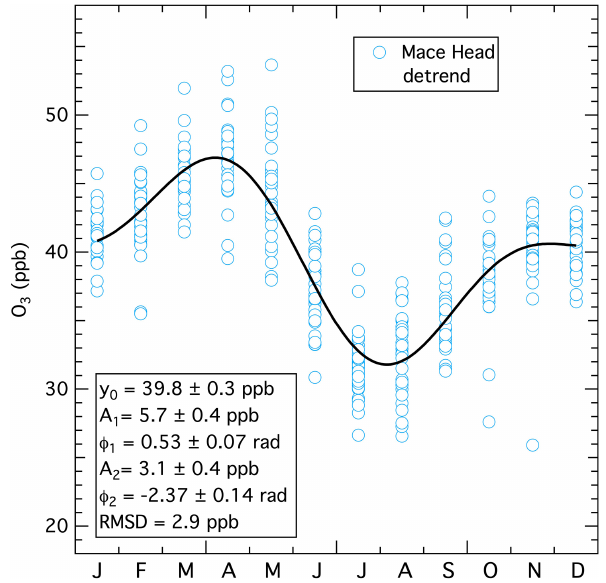
Figure 3. Results of the fit of Eq. (3) to the detrended monthly mean concentrations. The black curve is the nonlinear regression fit to the plotted